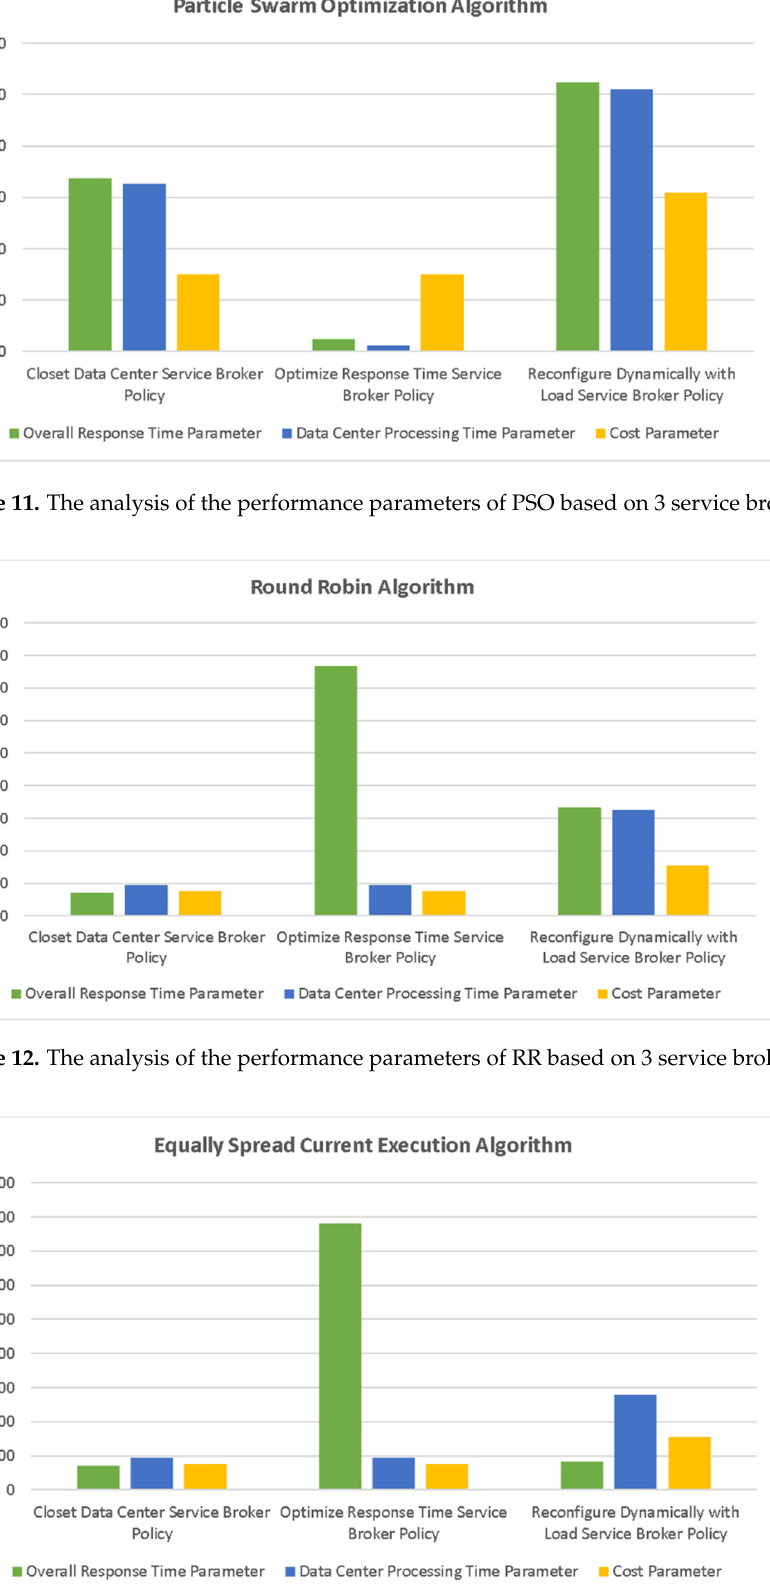
Figure 14. The analysis of the performance parameters of the throttled algorithm on 3 service broker policies. 4.2. Comparison of Load-Balancing Algorithms’ Results To analyze and compare the results of LB algorithms obtained by executing the above set of algorithms, the results compare PSO, RR, ESCE, and throttled LB algorithms by considering the overall response time, DCPT, and cost parameters for each of the three service broker policies, which are CDC, optimize response time, and reconfigure dynam- ically with the load. 5. Discussion The findings compare the PSO, RR, ESCE, and throttled LB algorithms by taking into account overall response time, DCPT, and cost parameters for each of the CDC, optimiz- ing response time, and reconfiguring dynamically with load service broker policies. 5.1. Closest Data Center Service Broker Policy The observation in this CDC SBP is that the two LB algorithms RR and ESCE perform almost the same for overall response time, DCPT, and cost parameters, but throttled and PSO algorithms performed higher than RR and ESCE LB algorithms. However, the values of DCPT and cost parameters are almost the same for PSO, RR, ESCE, and throttled. This